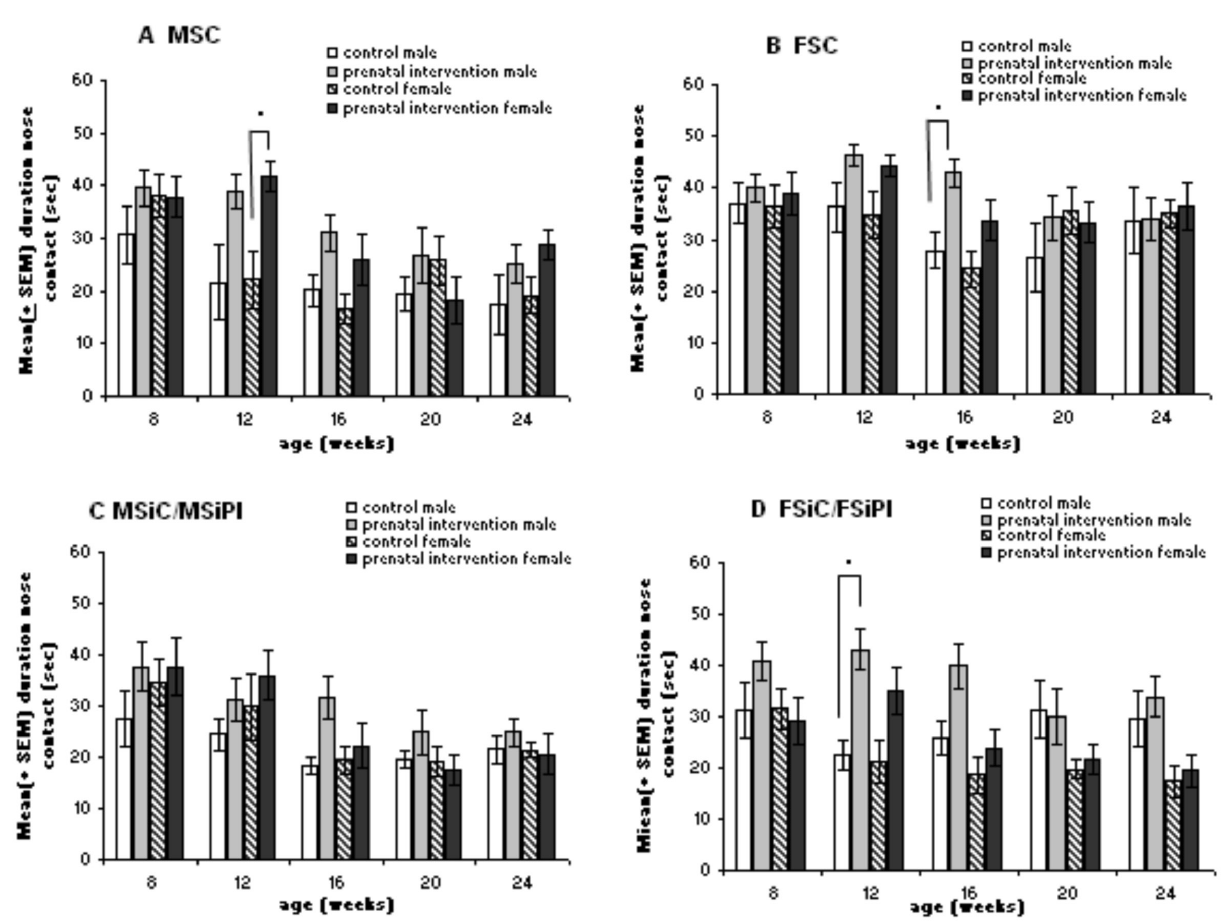
Figure4 - Social interaction test. Nose contact within 60 seconds for male (n = 5-9) and female (n = 8-13) control and male (n = 12-13) and female (n = 9-11) prenatal intervention groups with different partners** was measured at weeks 8, 12, 16, 20 and 24. In general, male and female prenatal intervention groups showed a greater extent of social contact than controls, depending on the degree of kinship. At week 12, there were differences between male and female controls and male and female animals which received prenatal intervention with MSC and FsiC/FSiPI as partners, and at week 16 for the male rats with FsiC/FsiPI as partners; *p ≤ 0.01. ** MSC = male strange control; FSC = female strange control; MSiC or MSiPI = m ale s ibling c ontrol or p renatal i ntervention; FSiC or FSiPI = f emale si bling c ontrol or p renatal i